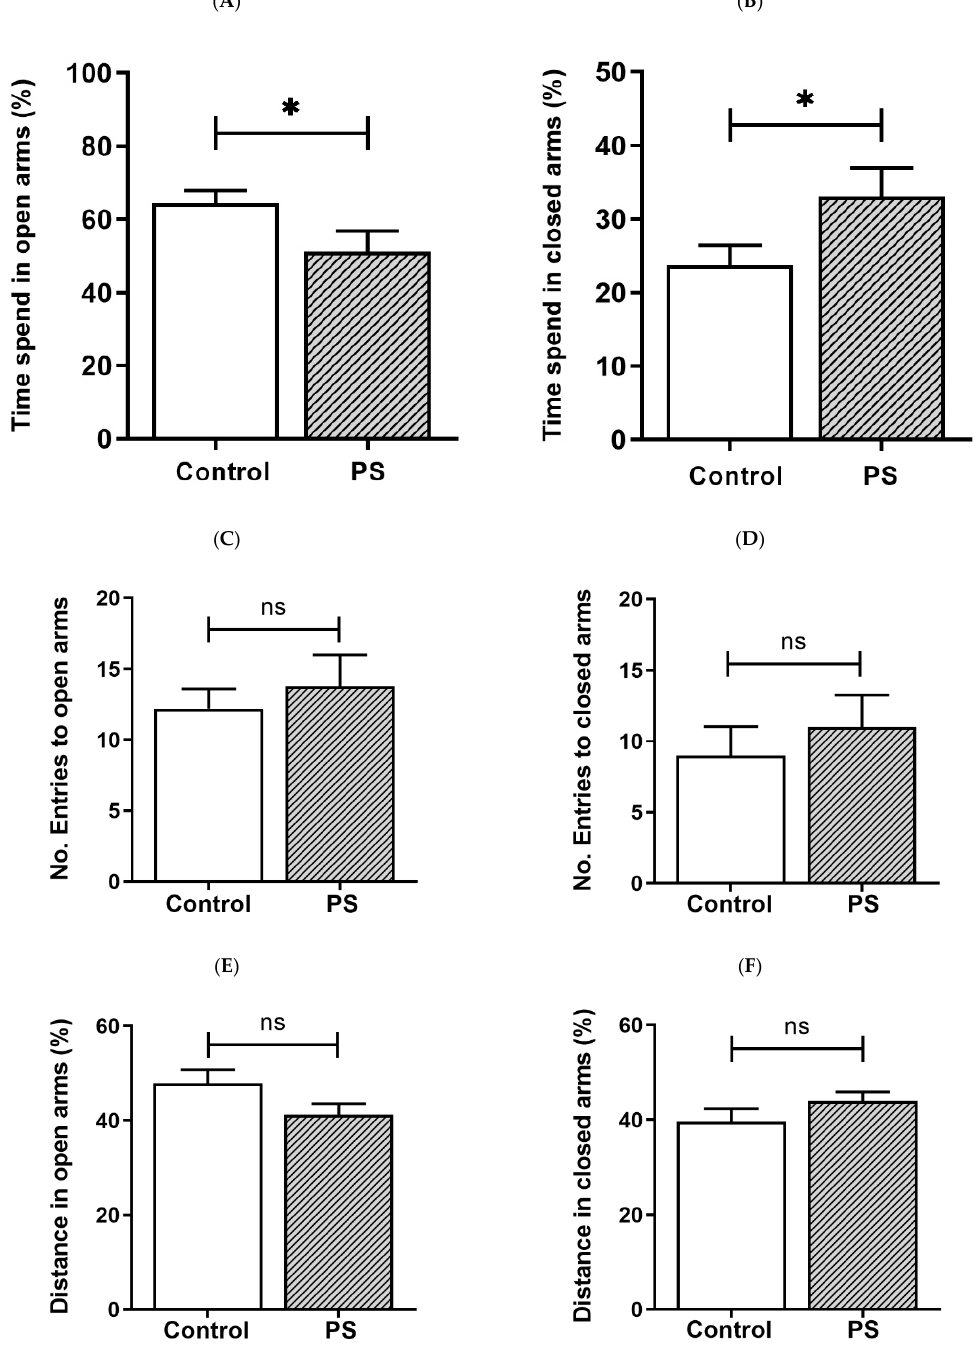
Figure 1. Anxiety-like behavior in adolescent rats. ( A ) Time spent in the open arms. ( B ) Time spent in the closed arms. Bar graphs display the results from the percentage calculation compared between the control and prenatal stress (PS) groups; the significant differences are at * p < 0.05. ( C ) Number of entries into the open arms. ( D ) Number of entries into the closed arms. Bar graphs display the results from counted number calculation compared between the control and PS groups; non-significance